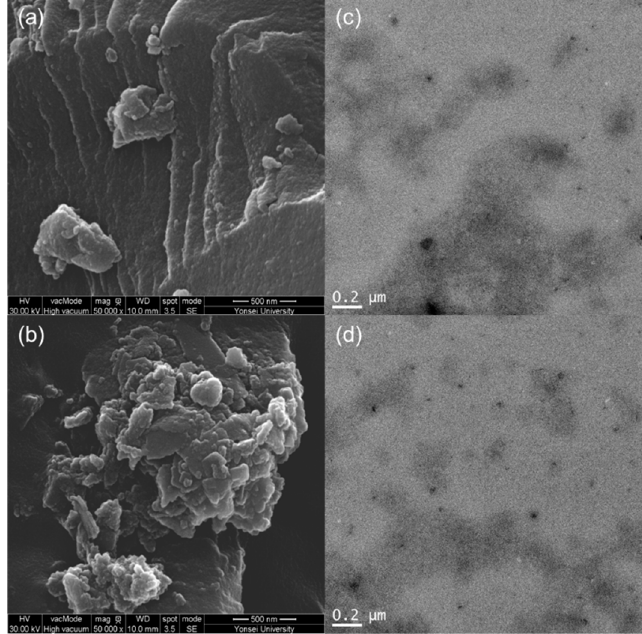
Figure 8. Morphology of NPSN. SEM images ( a , b ) and TEM images ( c , d ).